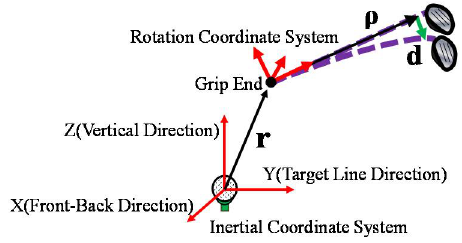
Figure 2. Vectors demonstrating each position on the golf club model. r is the vector for the direction from the ball position to the grip end and ρ is the vector for the direction from the grip end to the origin of an arbitrary node on the shaft coordinate. d is the displacement of the